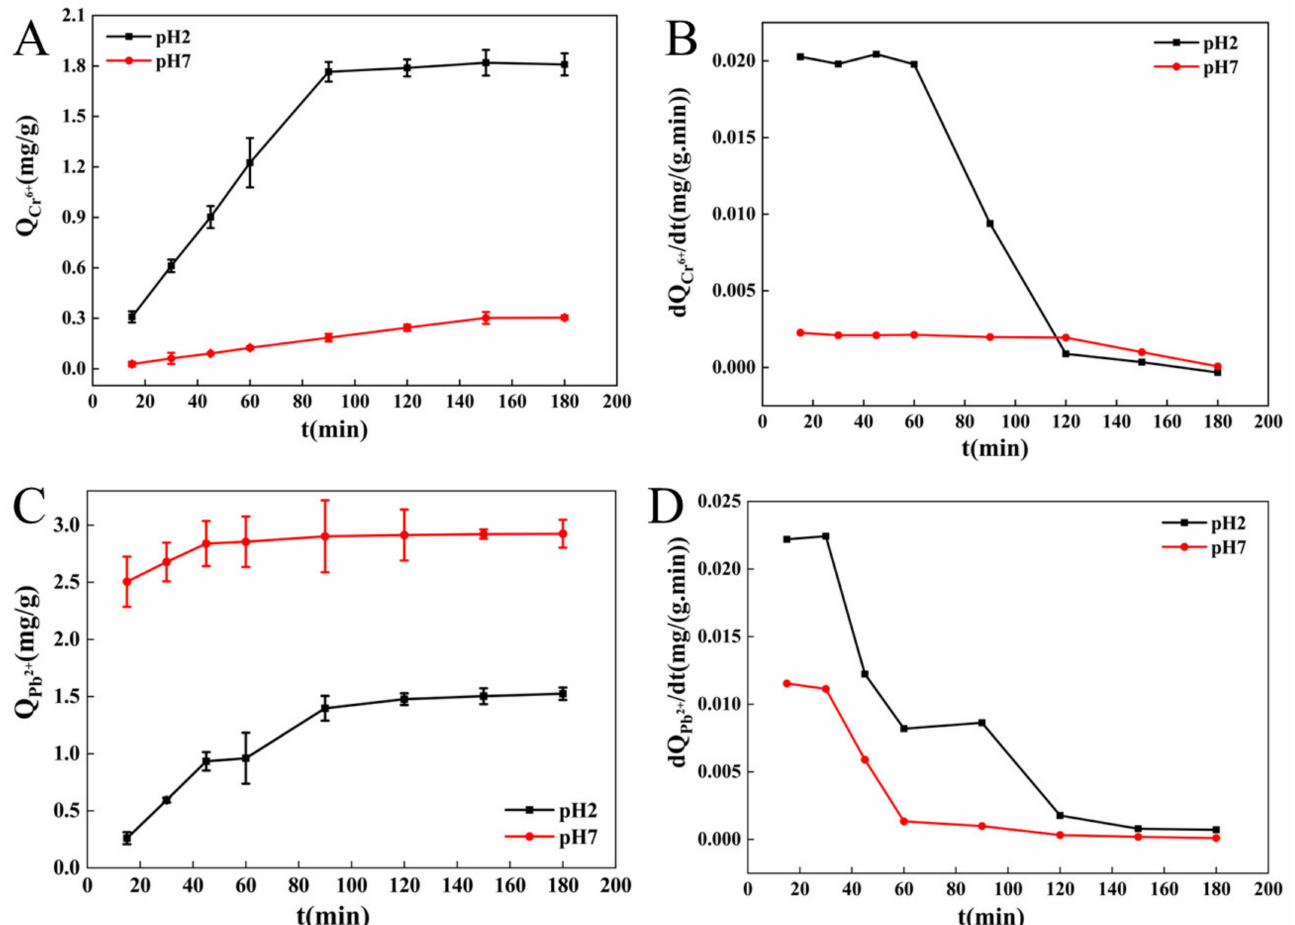
Figure 4. Adsorption of Cr 6+ ( A ) and Pb 2+ ( C ) and adsorption speed curves of Cr 6+ ( B ) and Pb 2+ ( D ) onto BC at different